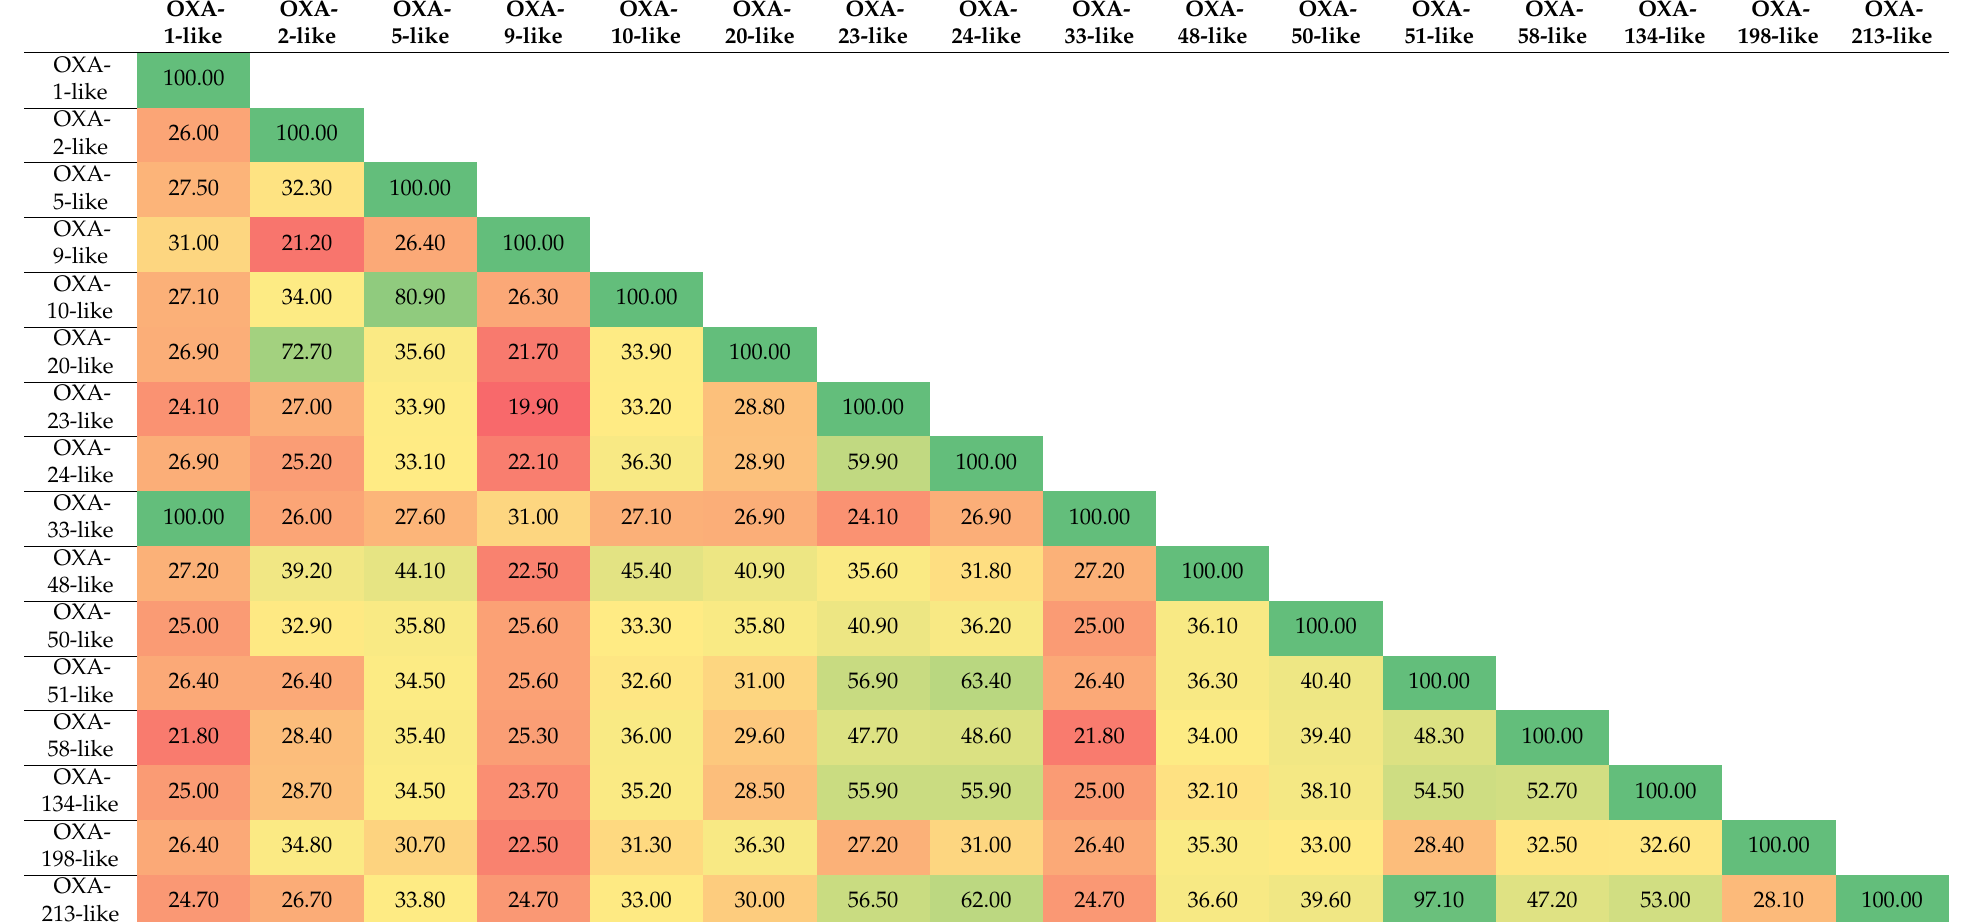
The color scale is from highest (green) to lowest